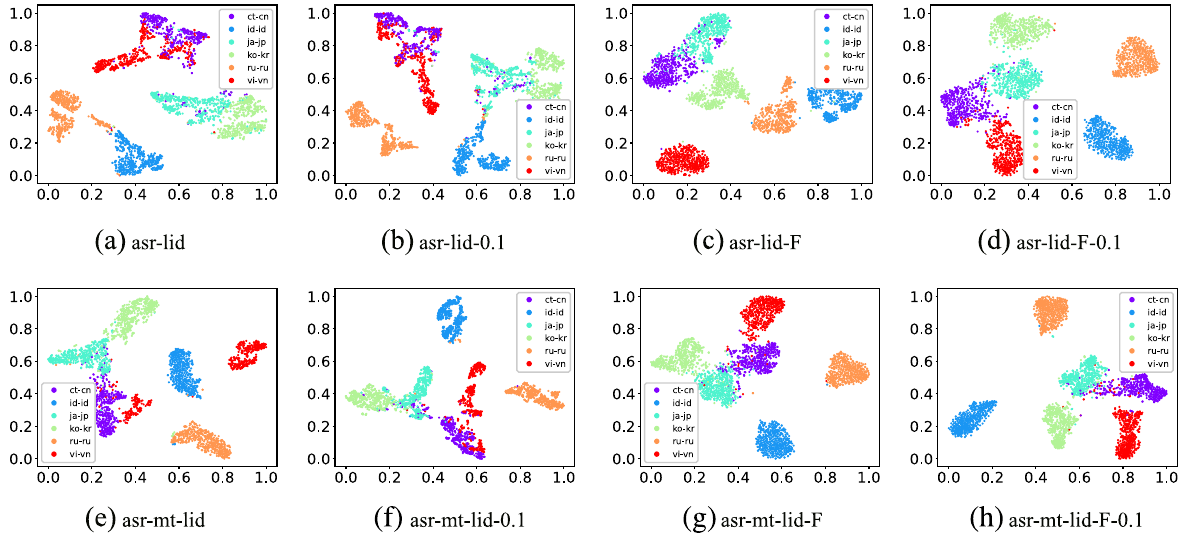
Fig. 6 Language embeddings of different training strategies, plotted by t-SNE on channel-test . Each color represents a different language. Models are named by their strategies plus the value of (cid:31) and correspond to those in Table 4